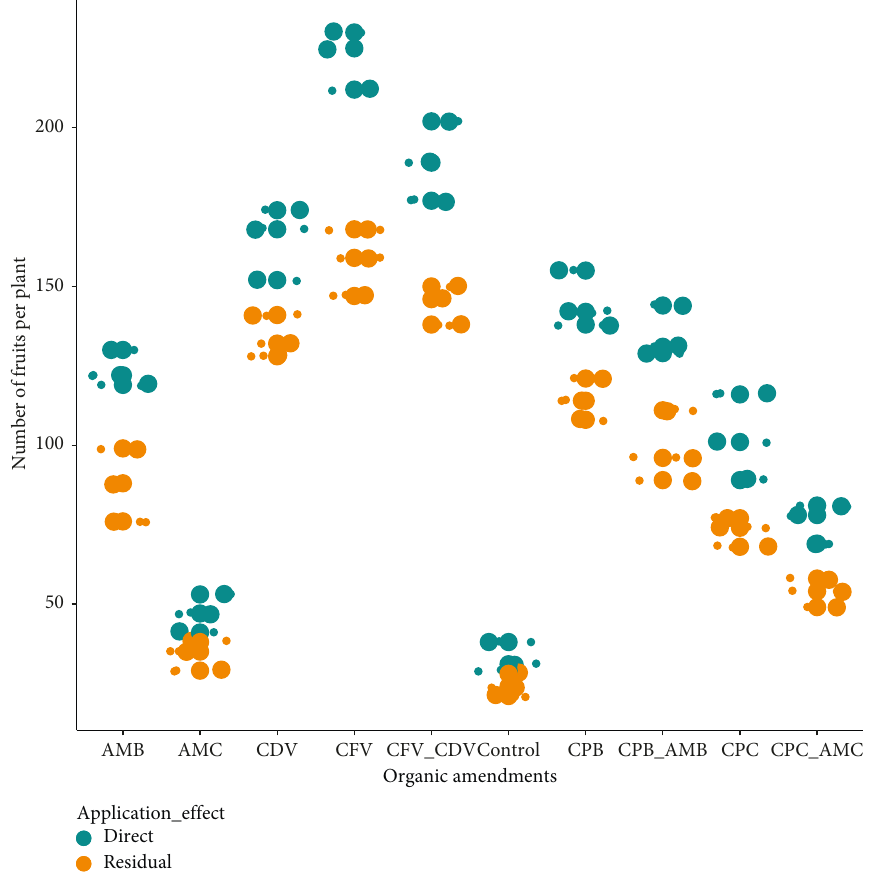
Figure 9: Number of fruits per plant in direct and residual effects of organic